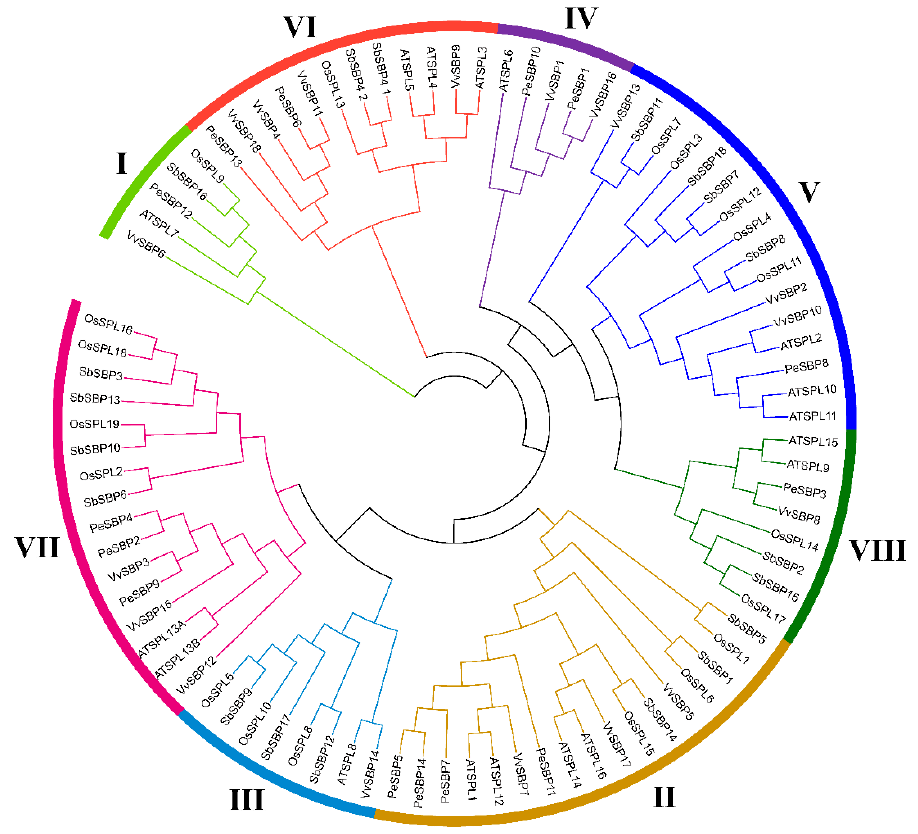
Figure 3. Phylogenetic tree of SBP family proteins among passion fruit, rice, Arabidopsis , grape, and sorghum. Pe, Passiflora edulis Sims; Os, Oryza sativa ; AT, Arabidopsis thaliana ; Vv, Vitis vinifera ; and Sb, Sorghum bicolor .